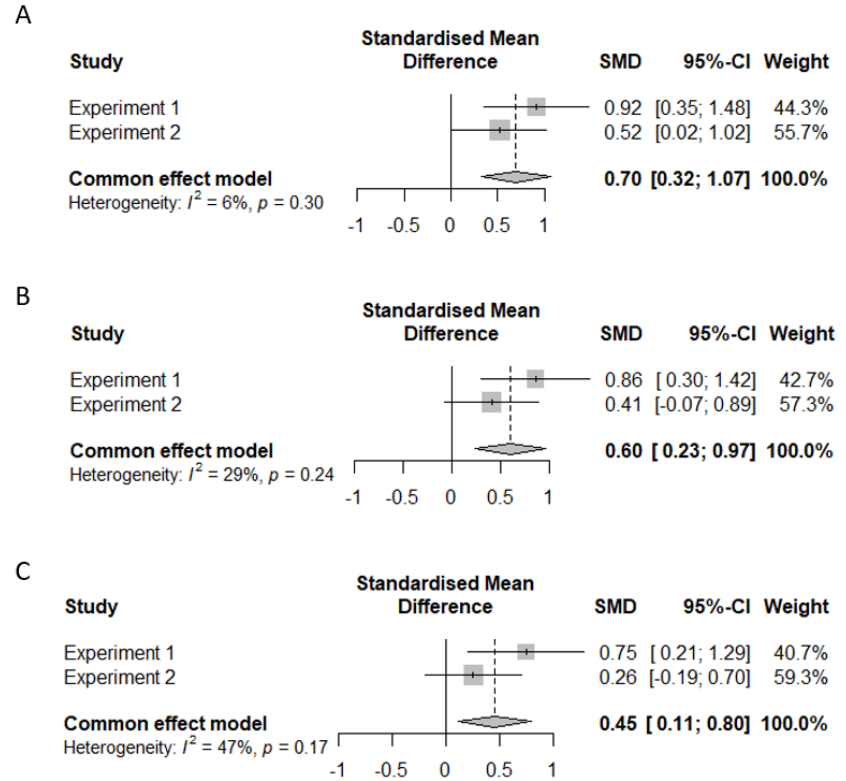
Figure 4. Meta-analysis of JOL accuracy for related items. ( A ) Effect sizes without adjustment for correct guessing. ( B ) Effect sizes with adjustment of correct guessing. ( C ) Effect sizes with adjustment for correct guessing and low confidence. Effect sizes are Hedges’ g .